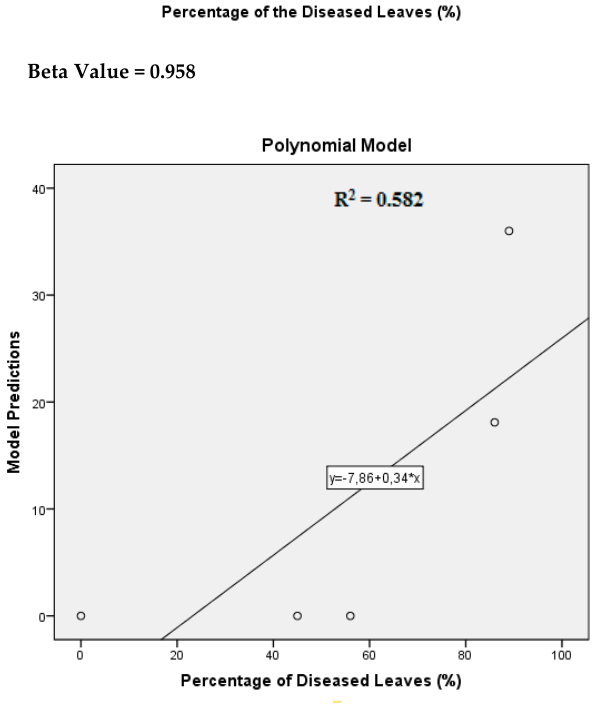
Figure 5. Relationship between model (generic and polynomial) predictions and percentage of diseased leaves.